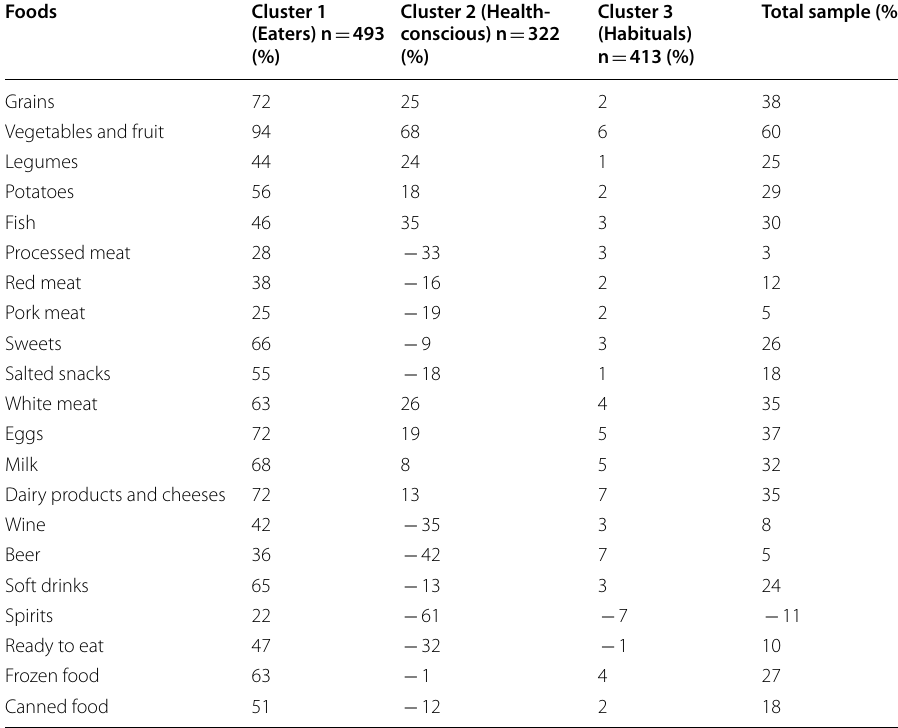
Table 5 Average values in percentage variations in quantities referring to post-lockdown compared with before the pandemic for the categories studied in the three clusters Foods Cluster 1 Cluster 2 (Health- (Eaters) n conscious)